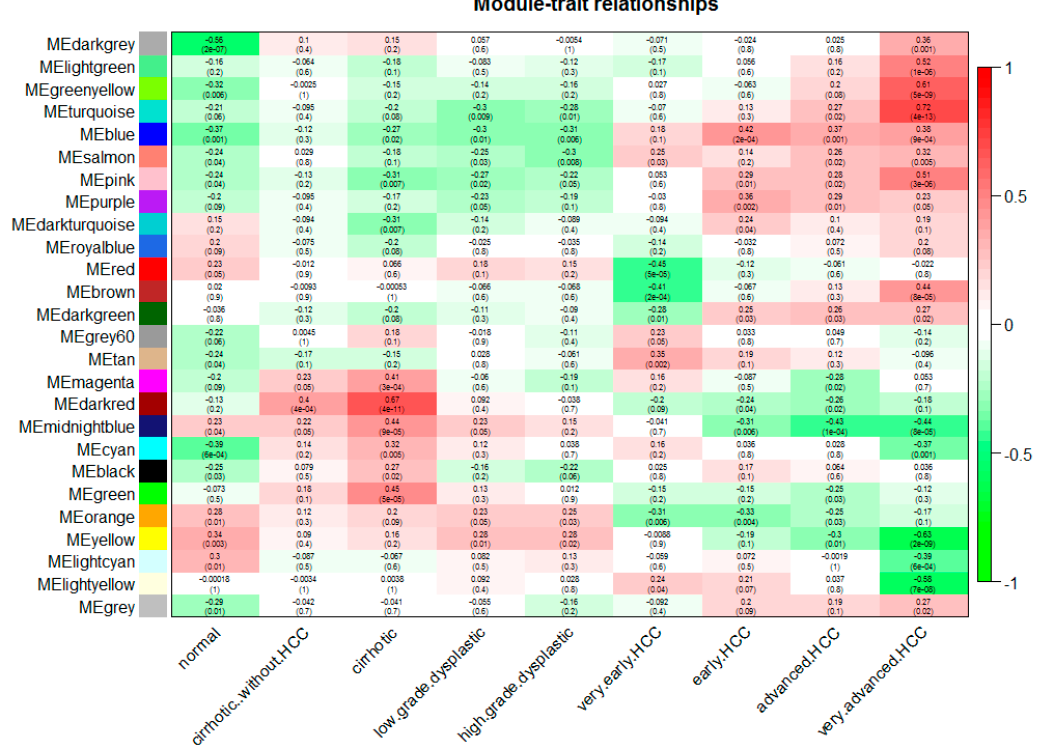
Figure 3. Relationships of consensus module eignegenes and different stages of hepatocellular carcinoma (HCC). Each row in the table corresponds to a consensus module, and each column to a stage. The module name is shown on the left side of each cell. Numbers in the table report the correlations of the corresponding module eigengenes and stage, with the p values printed below the correlations in parentheses. The table is color coded by correlation according to the color legend. Intensity and direction of correlations are indicated on the right side of the heatmap (red, positively correlated; green, negatively correlated).